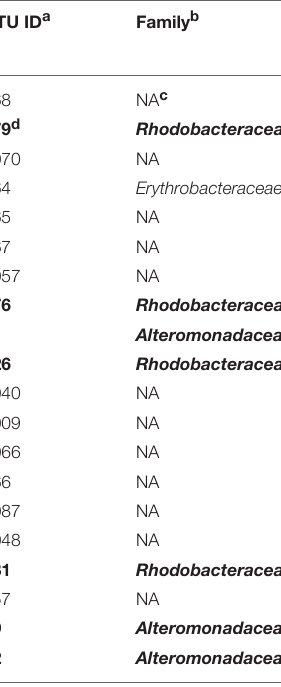
TABLE 2 | Identified “keystone” OTUs in co-abundance networks.